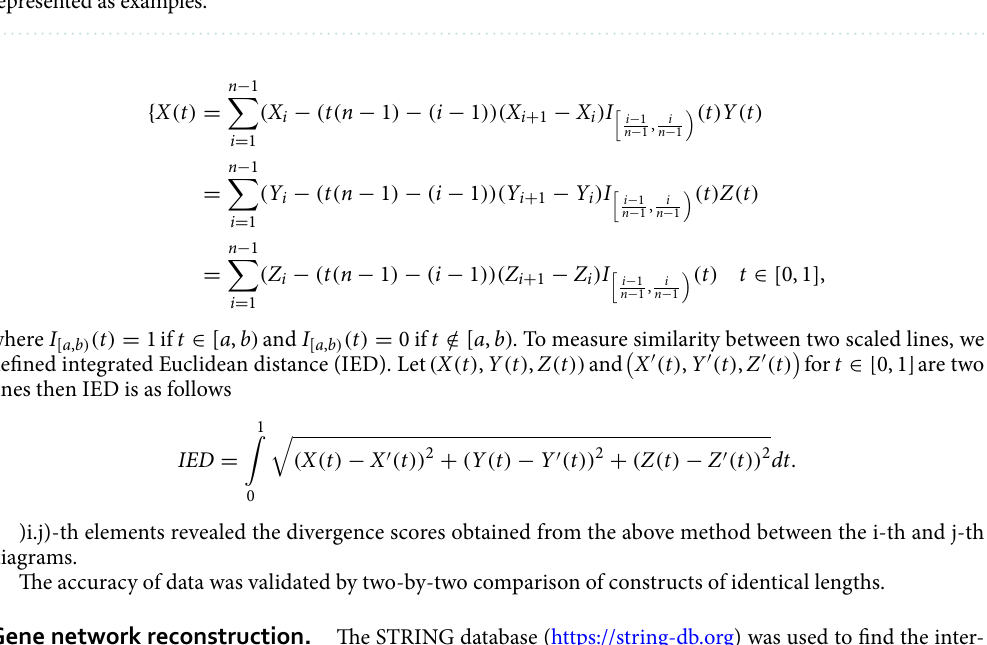
Figure 1. Strict monomorphism of the PRKACB (GCC)-repeat, at 7-repeats, in human. Only four samples are represented as